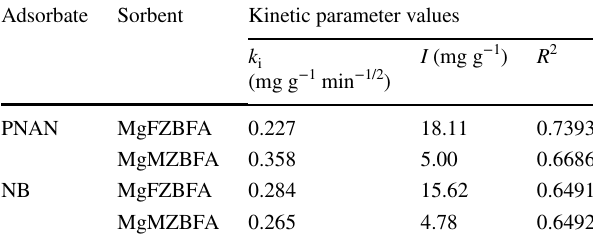
Table 9 Intraparticle diffusion kinetic model parameters for the sorp- tion of PNAN and NB on MgFZBFA and